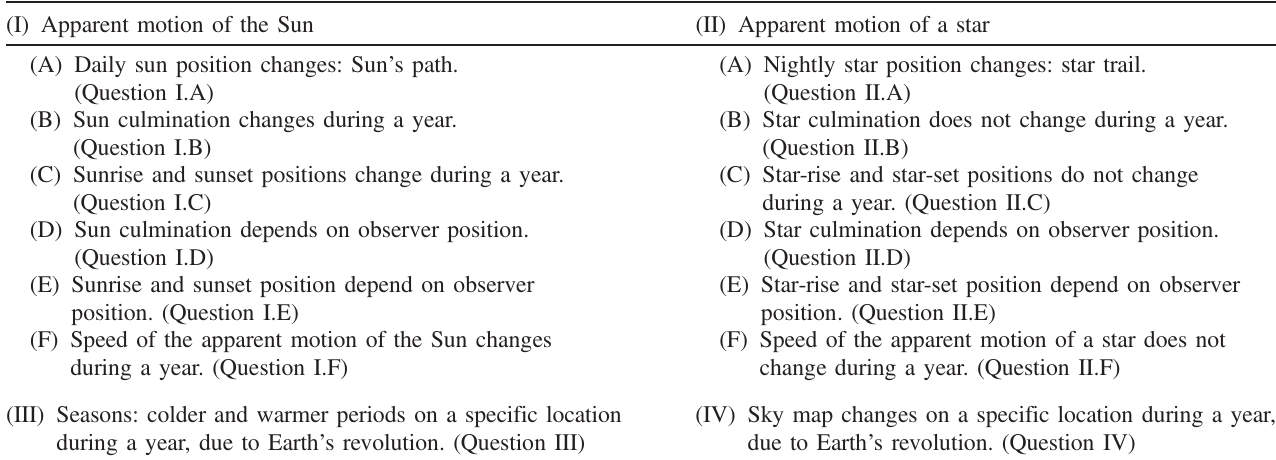
TABLE I. Initial framework of the AMoSS test: Similarities and differences between the apparent motion of the Sun and